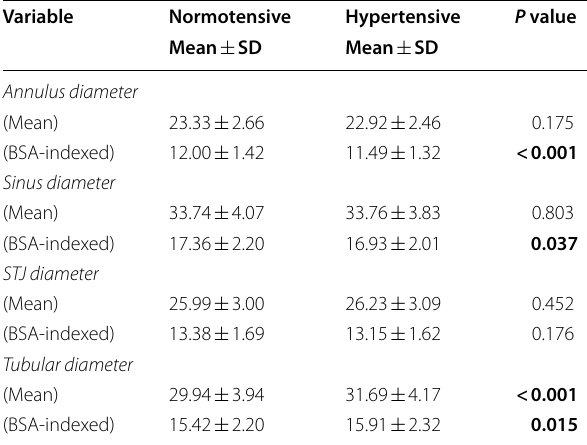
Bold mean significant values that is less than or equal